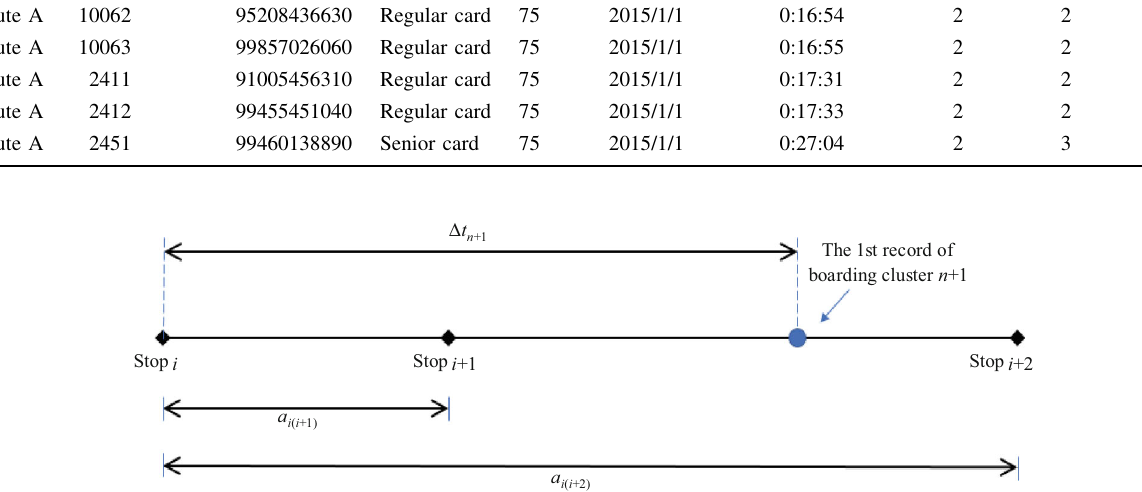
Fig. 3 Boarding information